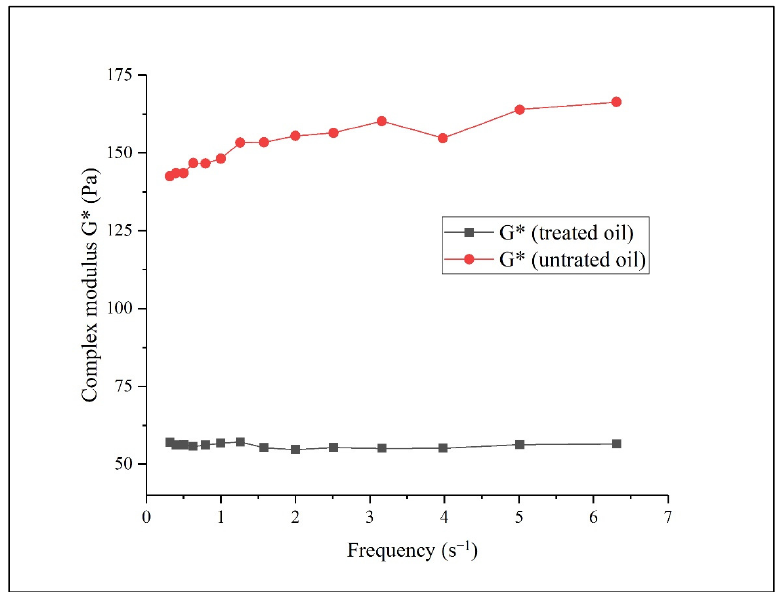
Figure 5. Complex modulus vs. the frequency of the crude oil before and after aquathermolysis at 25 °C.